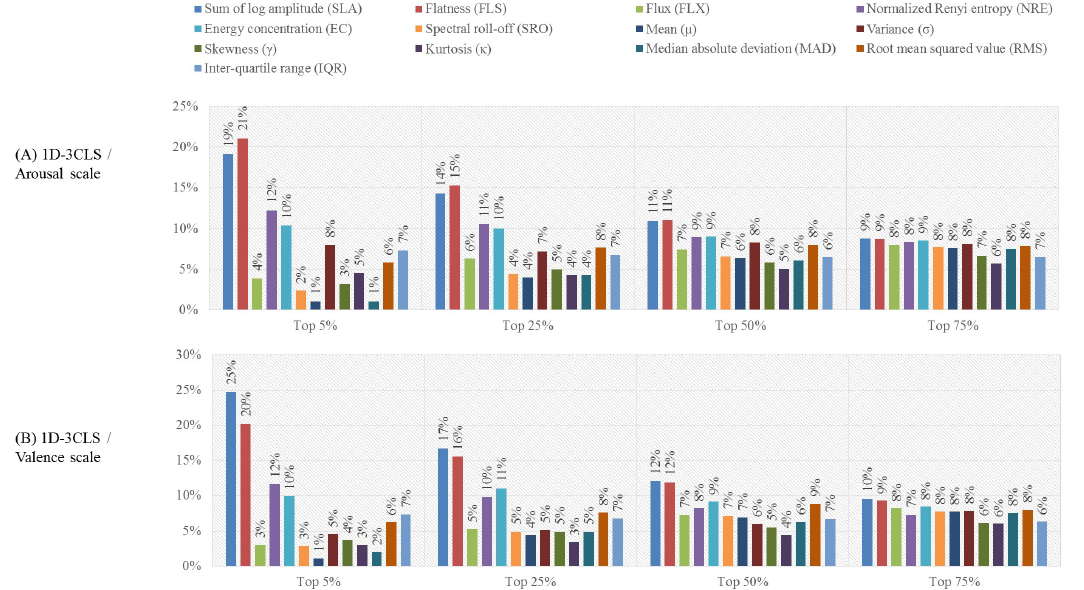
Figure 5. The ratio between the number of times each time-frequency feature is selected to the total number of selected features computed for each of the four feature selection scenarios. ( A ) presents the computed percentages for the 1D-3CLS using the arousal scale, and ( B ) shows the computed percentages for the 1D-3CLS using the valence